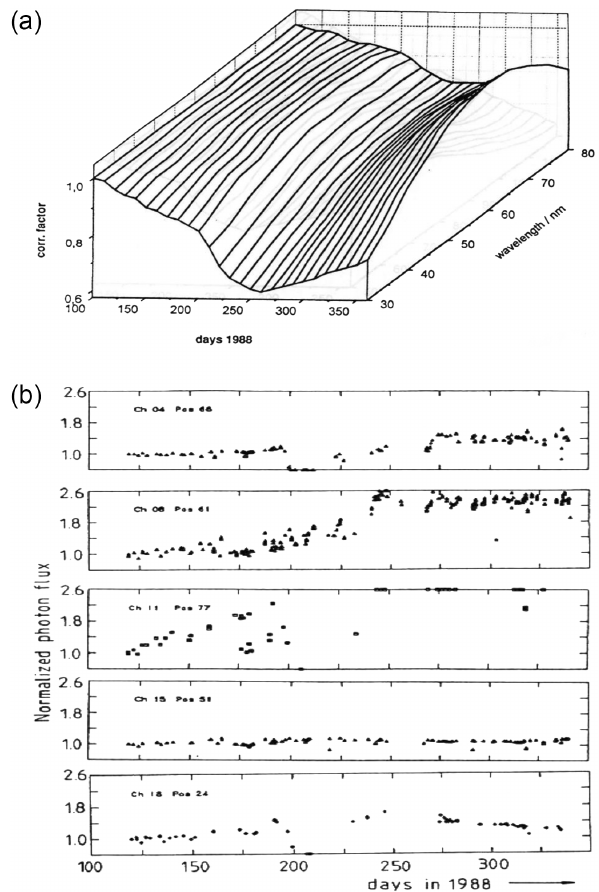
Figure 14. (a) Airglow-solar spectrometer instrument: efficiency changes of 1 channel (30–80nm) out of 18 channels covering the spectral range from 20 to 700nm (courtesy of J. Worden and T. Woods, 1996). (b) Airglow-solar spectrometer instrument: effi- ciency changes of five channels recording the solar emission line hydrogen Lyman- α at